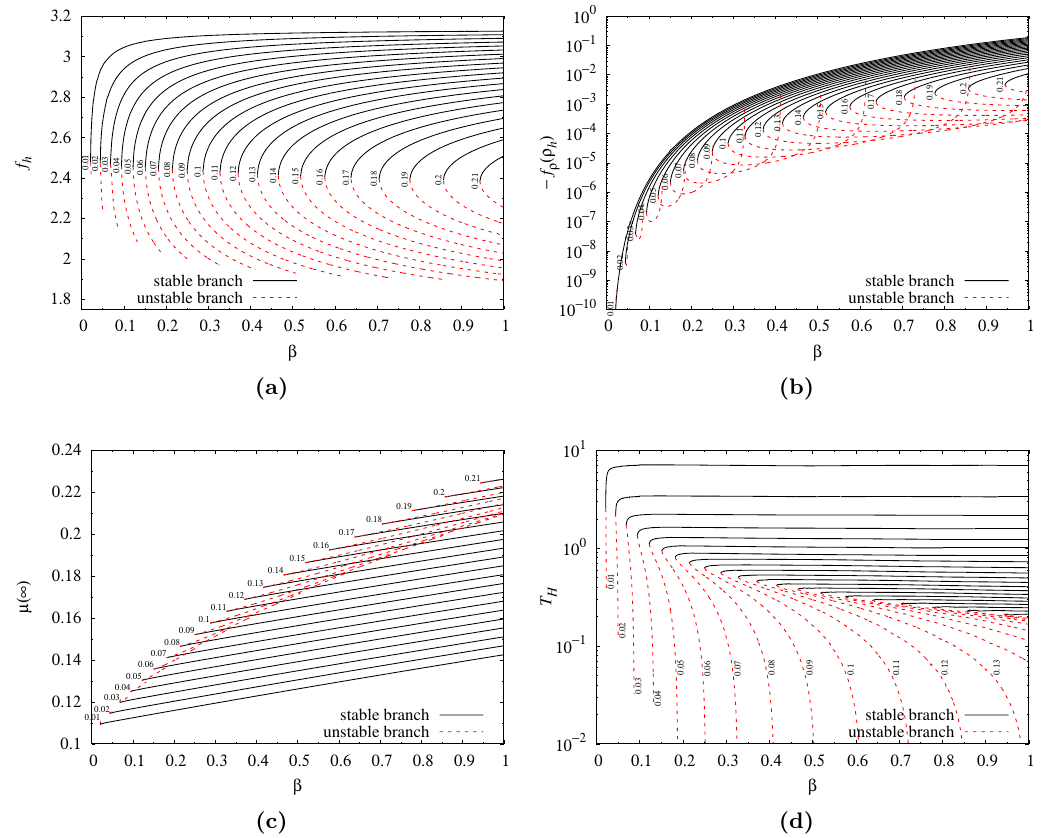
Figure 9 . Stable (black solid lines) and unstable (red dashed lines) branches of solutions in the 2 + 4 + 10 model: (a) the value of the pro(cid:12)le function at the horizon, f h ; (b) the derivative of the pro(cid:12)le function at the horizon, f (cid:26) ( (cid:26) h ); (c) the ADM mass, (cid:22) ( 1 ); (d) the Hawking temperature T H , all as functions of the Skyrme-term coe(cid:14)cient, (cid:12) . The numbers on the (cid:12)gures indicate the di(cid:11)erent values of (cid:26) h = 0 : 01 ; 0 : 02 ; : : : ; 0 :